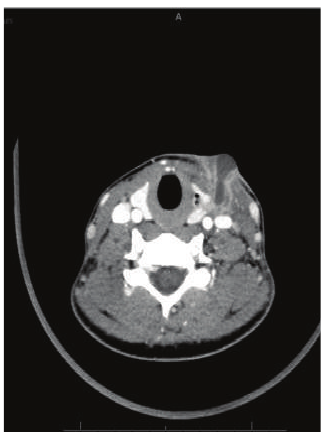
Figure 5: Axial CT-scan.